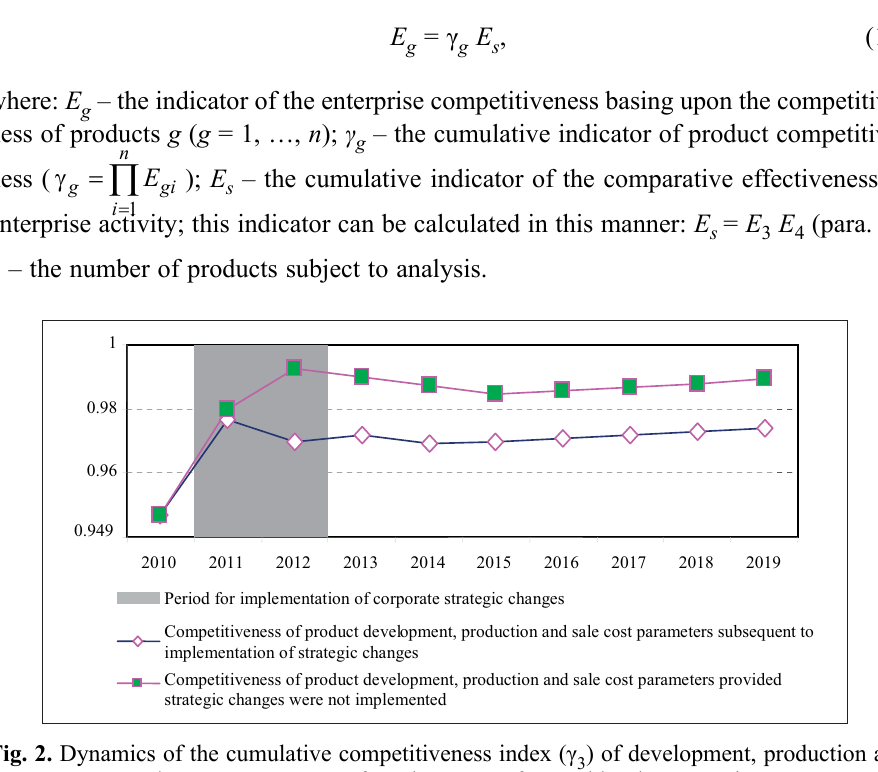
) of development, production 3